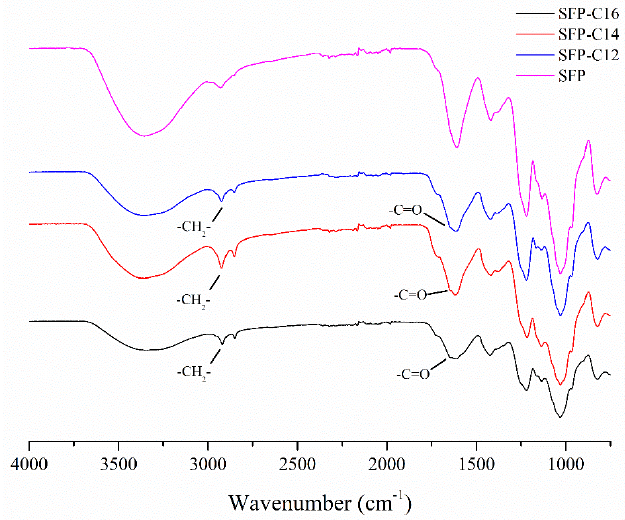
Figure 2. FT-IR spectra of SFP long-chain alkyl group